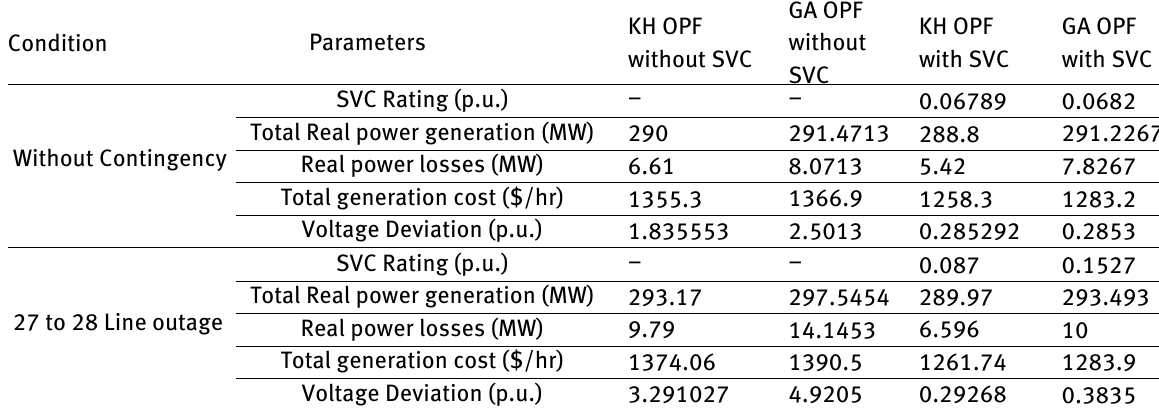
Table 9: Comparison of Real power losses, Cost and Voltage deviation for normal & line outage with SVC placed at bus number 30